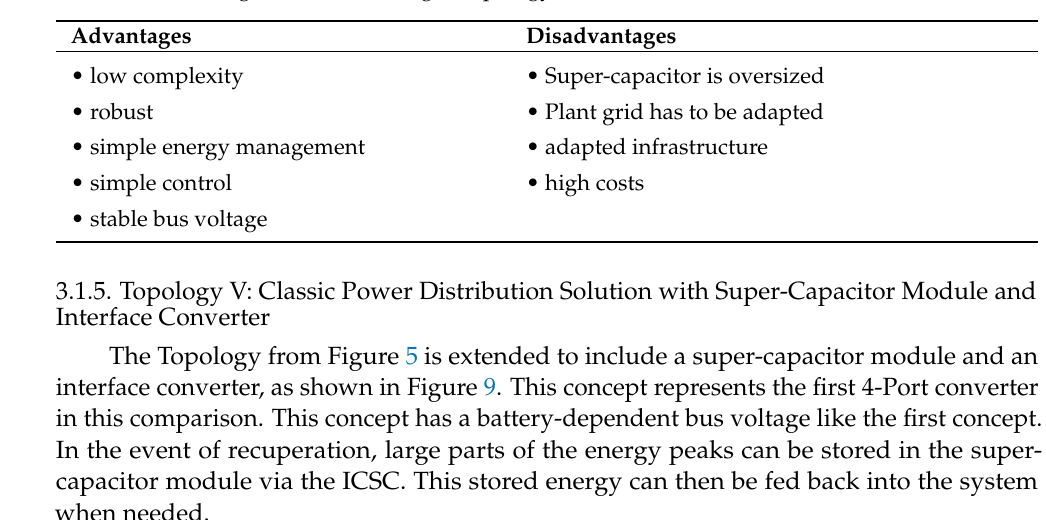
Table 11. Advantage and disadvantages Topology